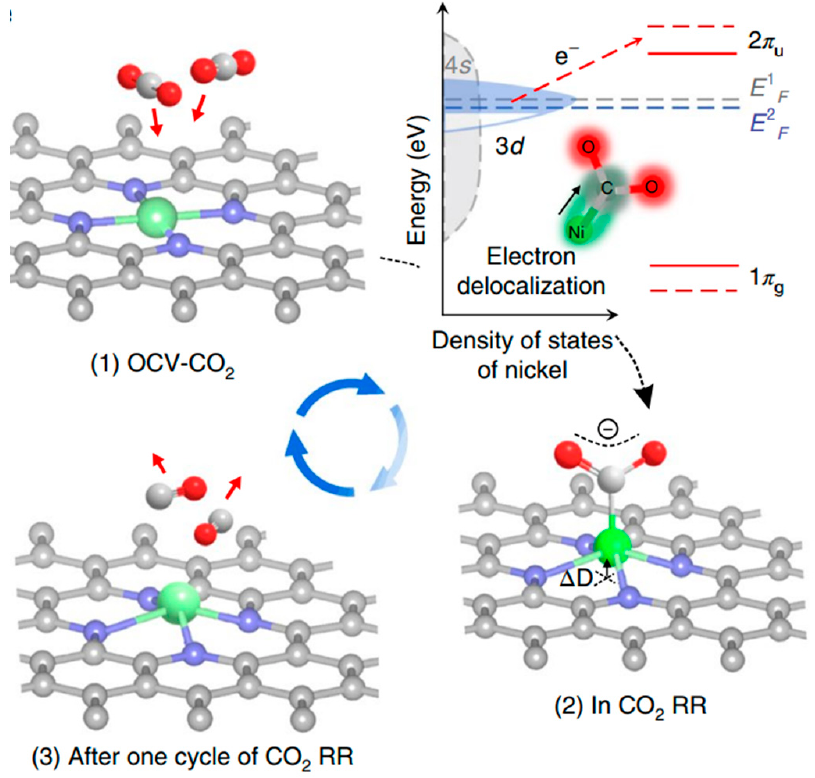
Figure 4. Structural evolution of Ni single-atom sites on graphene during CO 2 RR. ∆ D in shows the displacement of Ni atom out of plane resulting from electron transfer from Ni atom to CO 2 . The upper-right schematic shows the activation processes for CO 2 molecules on the Ni(i) site. A valence band structure, similar to metallic nickel, was used to simplify the schematic illustration. The red arrow represents the electron transfer from the Ni(i) to adsorbed CO 2 . E 1 and E 2 are Fermi levels of A-Ni-NG before and after formation of Ni-CO 2 , respectively. 1 π g and 2 π u are CO 2 molecular orbitals. (Reprinted with permission from Ref. [84]. Copyright 2018 SpringerNature).